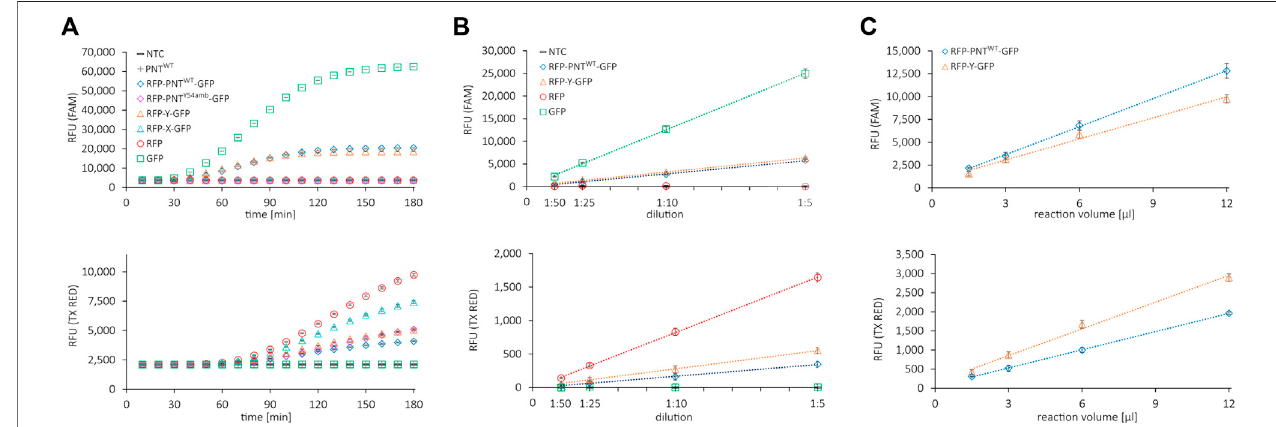
FIGURE 2 | Fluorescence properties of cell-free synthesized reporter proteins. (A) Live measurement of fl uorescence in the cell-free translation mix of various proteinsduringcell-freeproteinsynthesisintheFAMchannel(top)andtheTexasRedchannel(bottom). (B) Correlationofdilutionofthecell-freetranslationmixandNTC subtracted signal in the FAM channel (top) and the Texas Red channel (bottom). (C) Correlation of cell-free translation mix reaction volumeand NTC subtracted signal in the FAM channel (top) and the Texas Red channel (bottom). Mean values of triplicates are plotted with error bars representing their standard